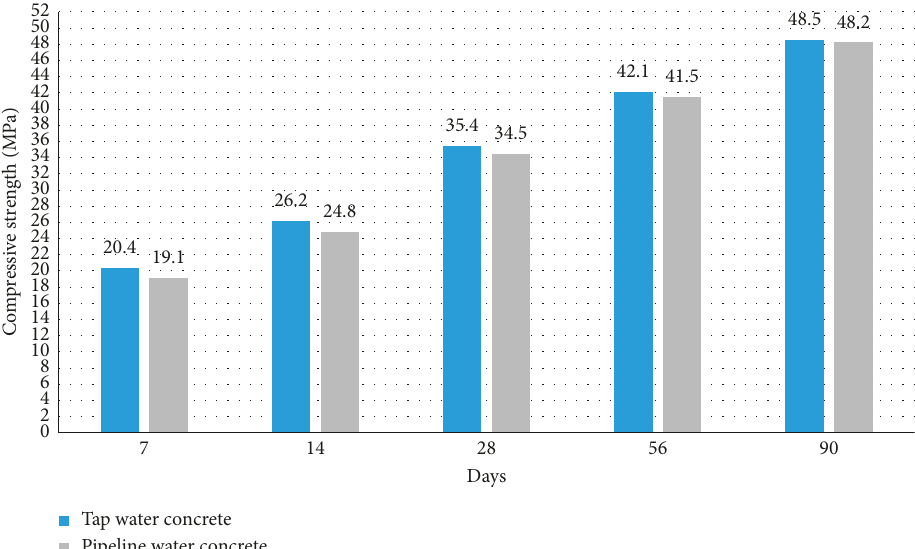
Figure 9: Comparison of compressive strength in tap water concrete and pipeline water concrete by replacing 50% of granite